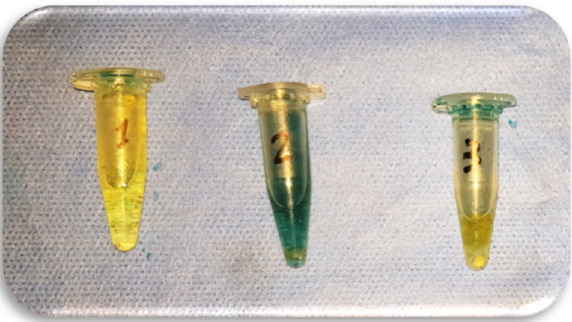
Figure 3. Dissolved roots with apical plug and pigment in nitric acid inside Eppendorf tubes.